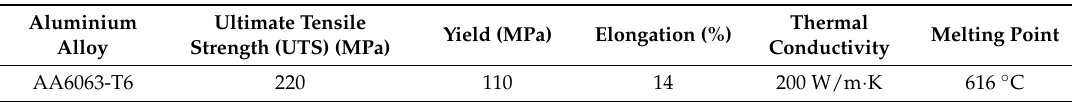
Table 2. Mechanical and thermal properties of AA6063-T6.